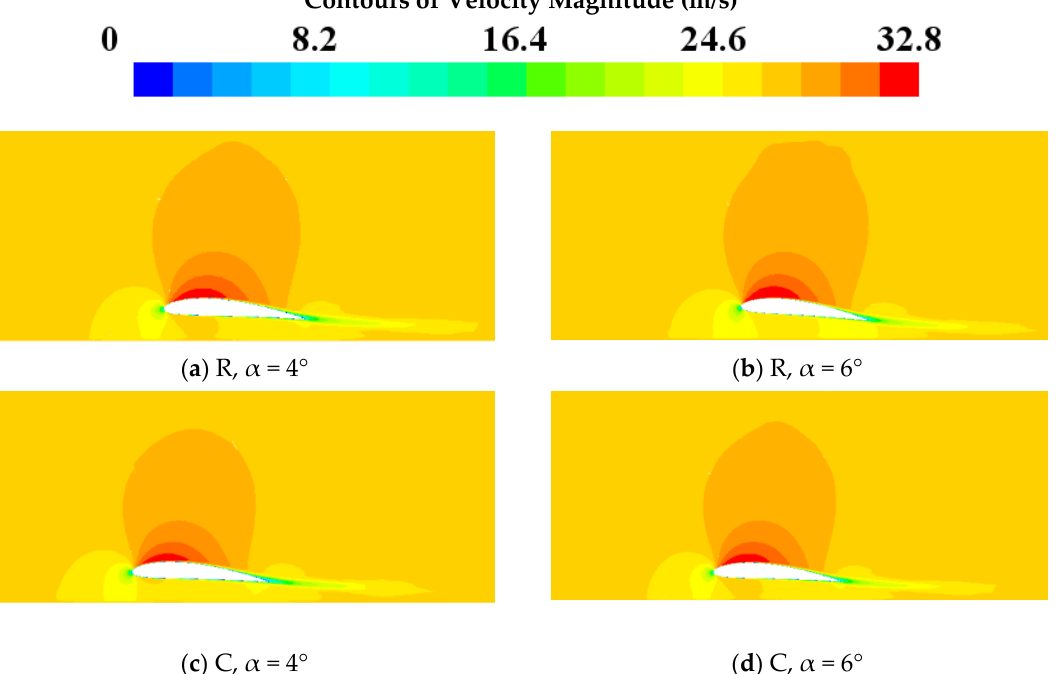
( d ) C, α = 6° Figure 8. Turbulent intensity (%) at the trailing edge of the compound wing (C) and the rectangular wing (R) with h/c = 0.15 for various attack angles ( α ). The variation of pressure coefficient ( C p) is shown in Figure 9 at the middle span of the surface of the compound wing and the rectangular wing at a low ground clearance of 0.15 for the various attack angles tested (4° and 6°). The positive pressure on the lower surface and negative pressure (suction effect) on the upper surface of both wings increased, thus augmenting the angle of attack.